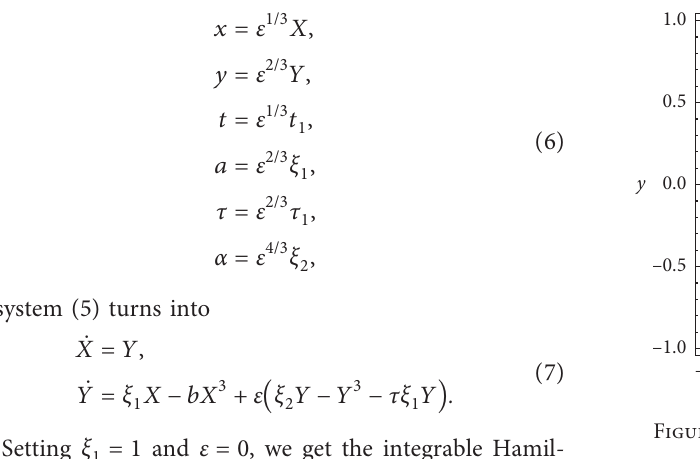
� 0 . 01 , f � 1, and τ � 0 . 3. 2 1